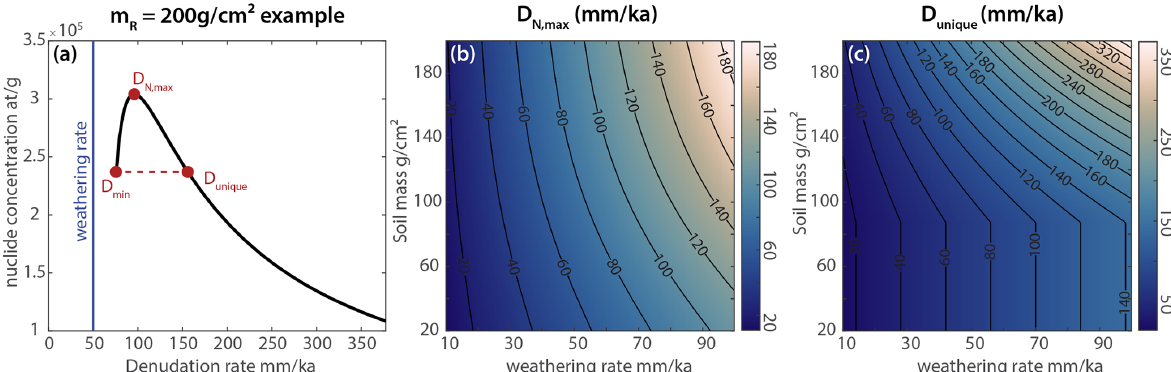
Figure 7. Weathering impact on the concentration of 36 Cl measured in pure calcite at SLHL. Ca B = 0 . 7, Q B = 0.3, and m R = 200gcm − 2 . (a) 36 Cl concentration versus denudation rate for calcite. The nuclide concentration increases above D min until D N higher than D unique , 36 Cl measurements would be unambiguous. (b) D N masses. (c) Same as (b) for D unique